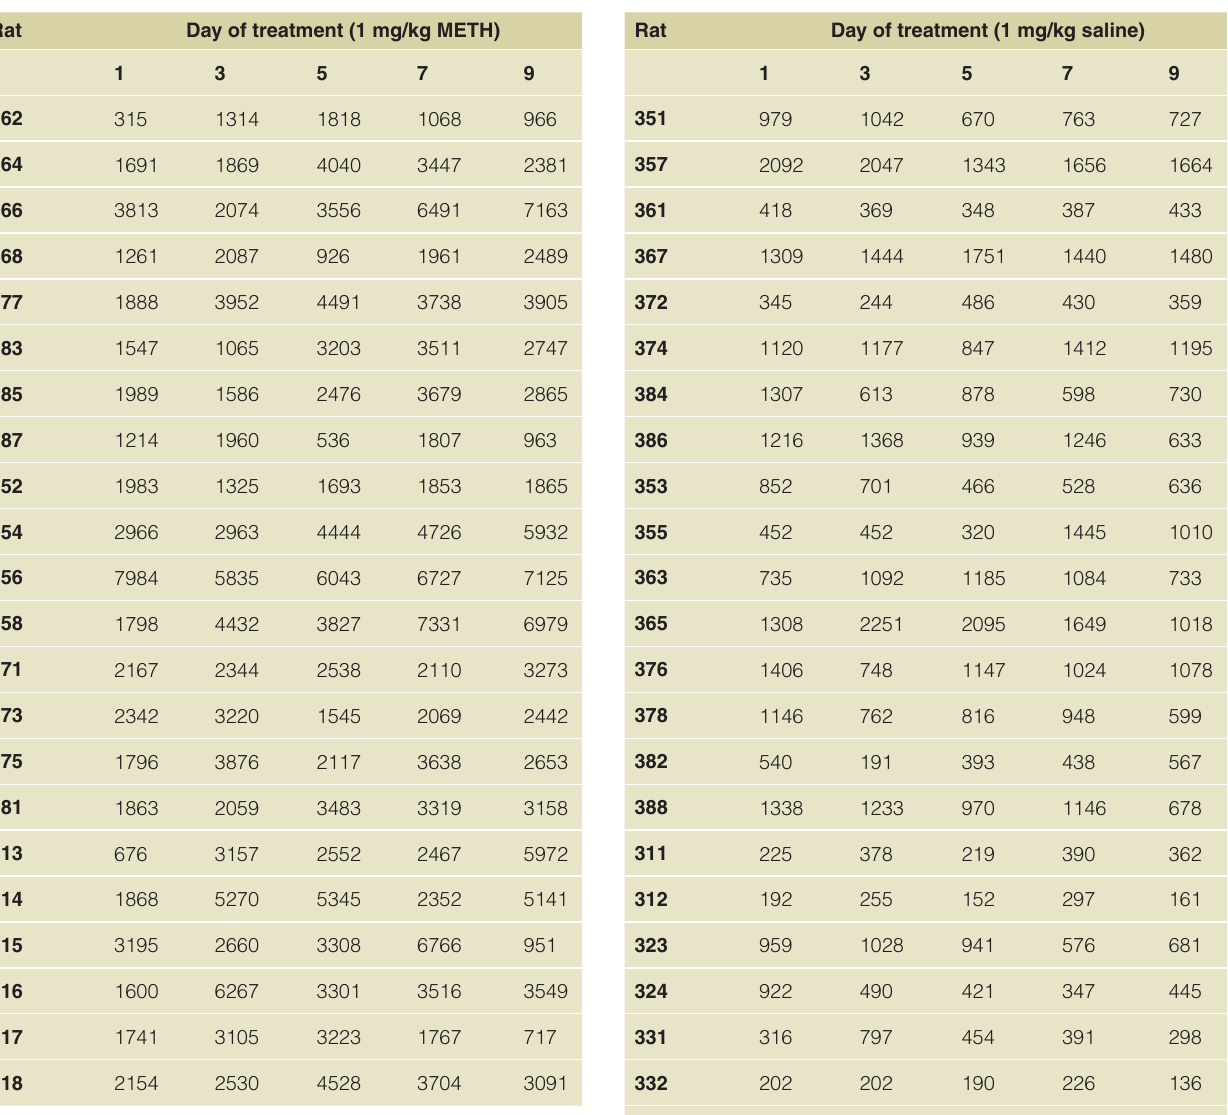
Table S3. Fenobam experiment – locomotor response (total quarter turns over 90 min) after chronic METH treatments. In locomotor sessions prior to mGluR5-targeted treatment, rats were chronically given 1 mg/kg METH i.p. In this experiment, the reported quarter turns progressively increased above first-day levels.